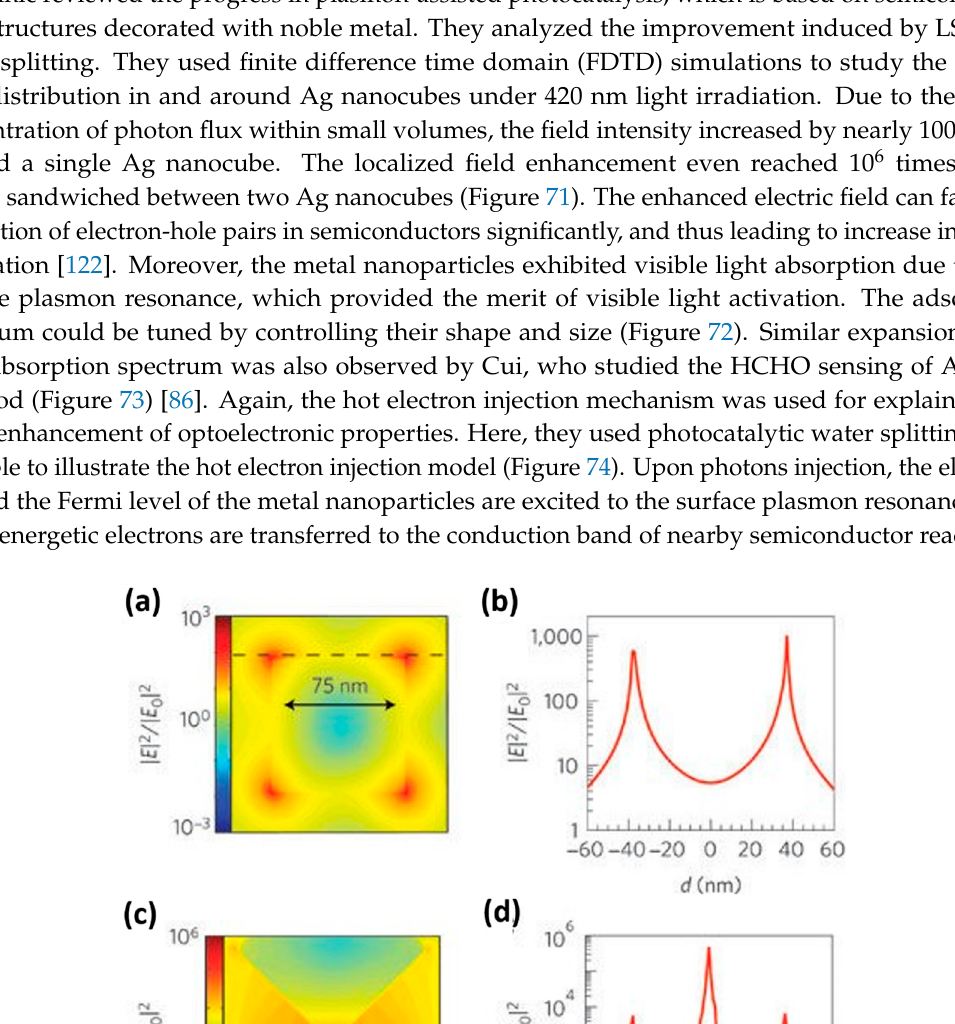
Figure 72. Normalized extinction spectra of ( a ) spherical Ag, Au, and Cu; ( b ) Ag nanoparticles with different nanostructure: wires, spheres, cubes; ( c ) Ag nanocubes as a function of size. The inset in ( c ) is an image of the Ag nanocubes of different sizes suspended in ethanol respectively. Reproduced with permission from [122].